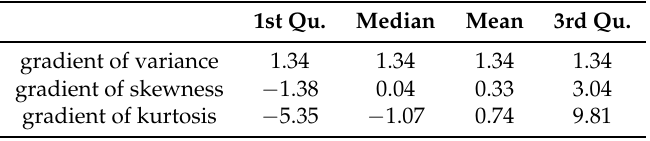
Table 5. Spline gradients summary statistics.